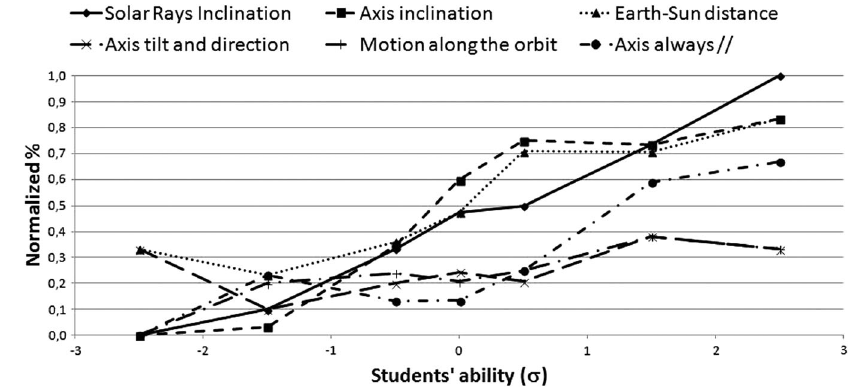
FIG. 4. Item response curves for seasons ’ change